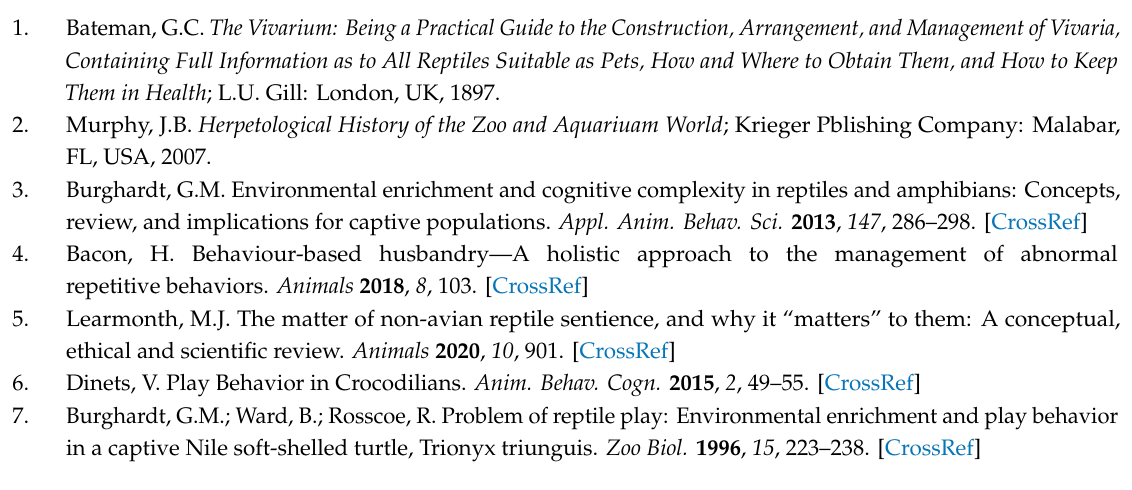
Table S1: Example Table with husbandry questions for Evidence Based Herpetoculture Protocol Development. Funding: This research received no external